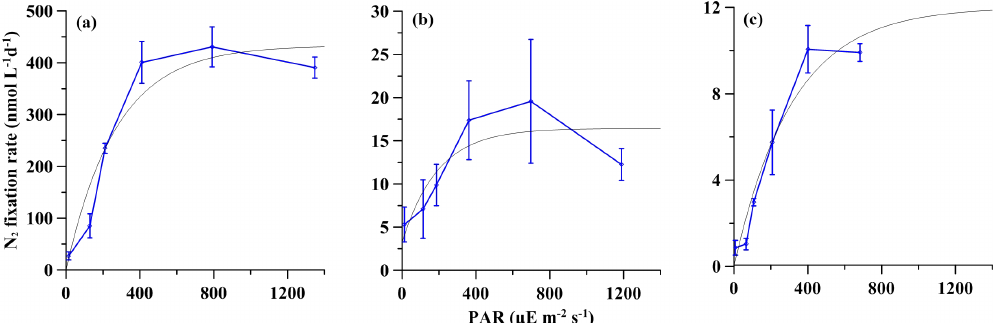
Figure 3. Net (particulate) NF versus irradiance. The gray curves represent the fitted NF-I curves. The error bar represents the standard deviation of triplicate incubations. (a) Station S0320; (b) station A3; (c) station D5.